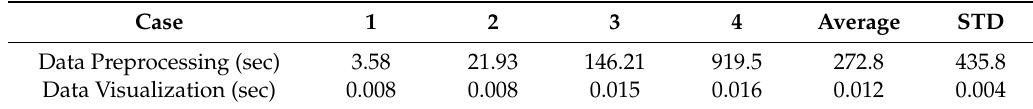
Table 5. PCD processing and rendering